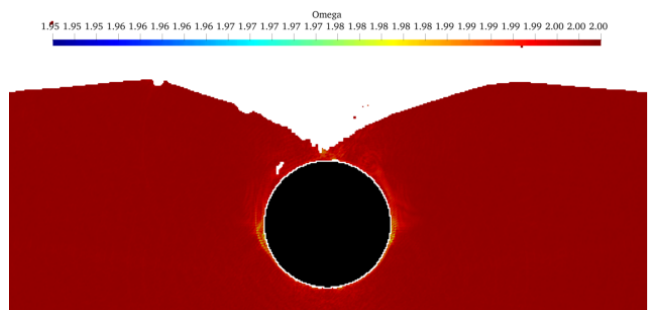
Figure 13. ω parameter when the obstacle is completely submerged at t (cid:63) = 2.4850 for Fr = 0.5772.